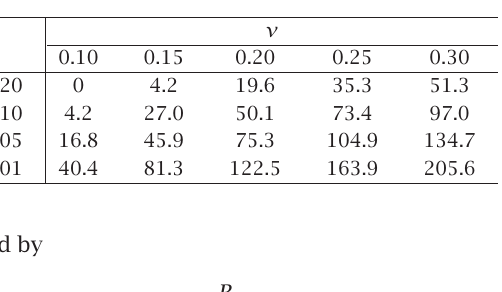
Table 3.3 . Maximum percentage one-year expected return for constant CVaR by varying confidence level and